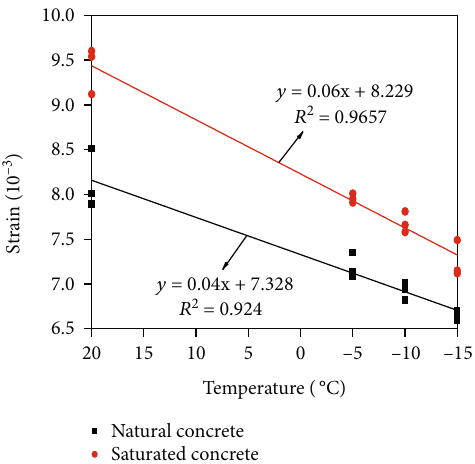
Figure 9: Relationship between peak strain and temperature of saturated concrete.